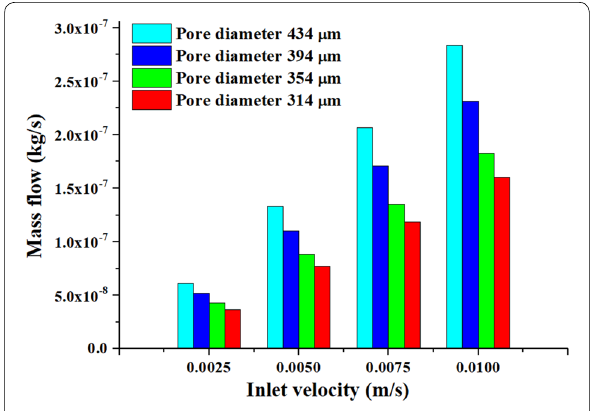
Figure 18 Mass flow in the side outlets obtained using CFD simulation